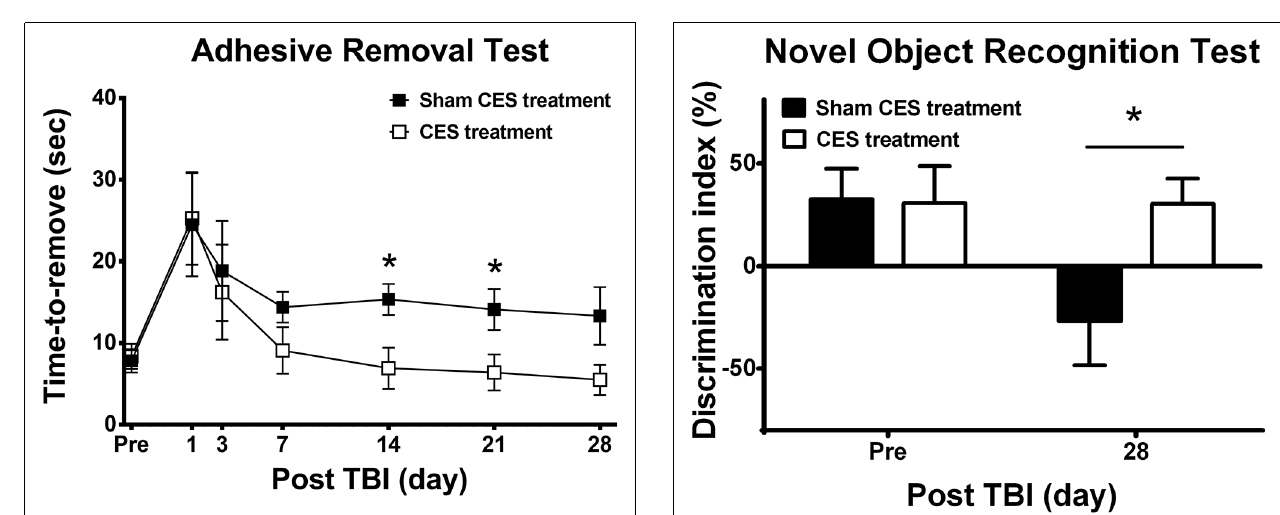
FIGURE 6 | Effect of CES treatment on recognition memory evaluated by the novel object recognition test. Values are expressed as the mean ± SEM. * p < 0.05, significant difference between the two